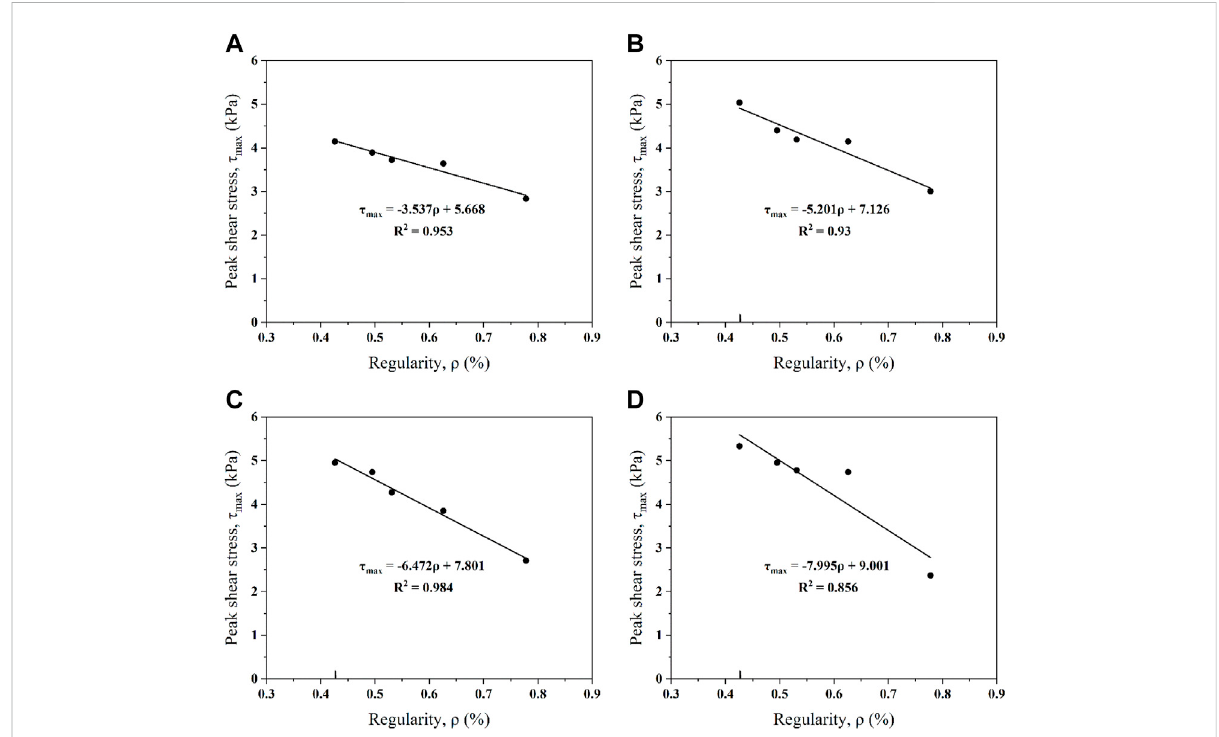
FIGURE 9 In fl uence of particle regularity on the maximum cyclic shear stress under different shear strain amplitudes: (A) A γ = 0.1%; (B) A γ = 0.2%; (C) A γ = 0.3%; (D) A γ = 0.4%.